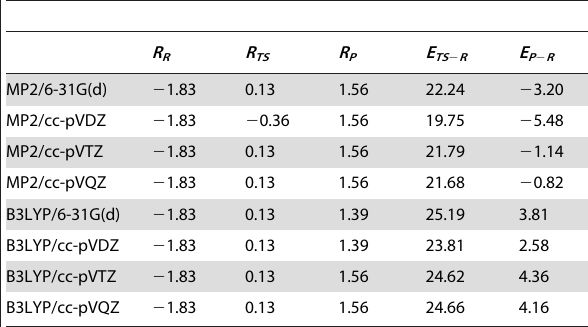
Table 2. Reaction barriers of chorismate mutase calculated using